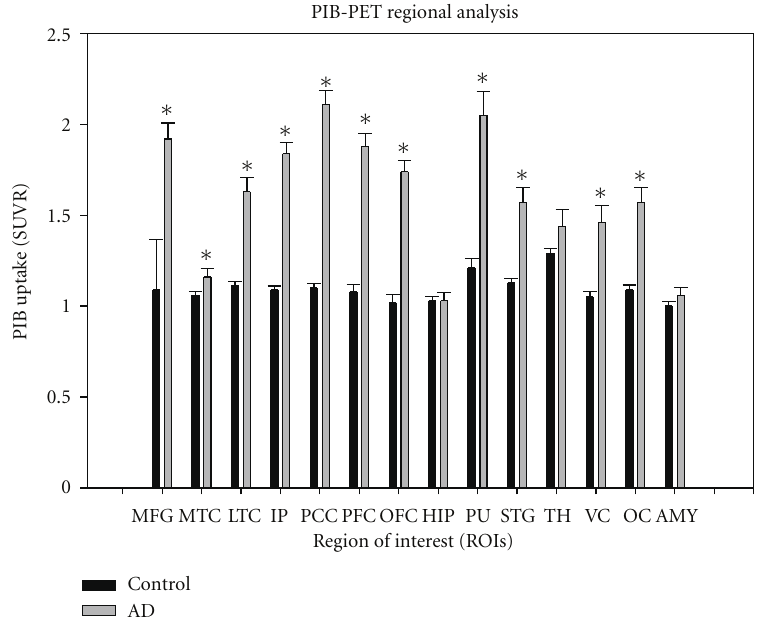
Figure 3: Regional PIB uptakes in normal control subjects and Alzheimer’s disease (AD) patients. Mean and SE of SUVRs for PIB-PET in various brain regions in normal (black bars) and AD subjects (gray bars). MFG: middle frontal gyrus, MTC: medial temporal cortex, LTC: lateral temporal cortex, IP: inferior parietal lobe, PCC: posterior cingulate cortex, PFC: prefrontal cortex, OFC: orbitofrontal cortex, HIP: hippocampus, PU: putamen, STG: superior temporal gyrus, TH: thalamus, VC: visual cortex, OC: occipital cortex, AMY: amygdala. ∗ P < . 05, two-tailed t